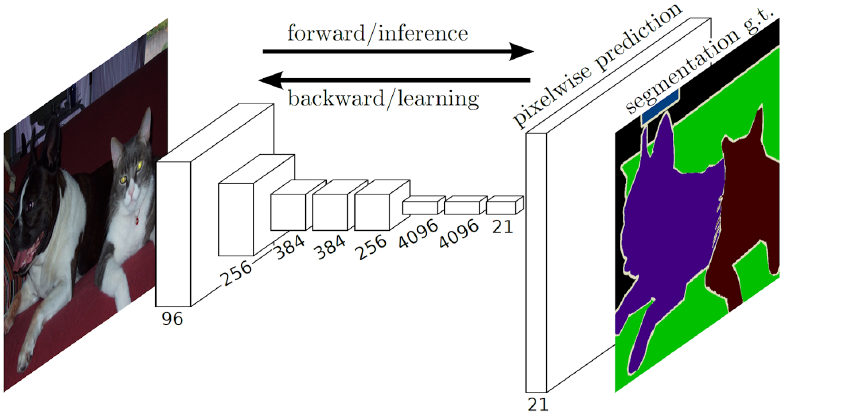
Figure 14. The explained architecture of Fully Convolutional Networks (FCNs). FCN first down- samples and then transforms the image back to the original spatial size using up-convolutions. Using dense predictions, it tries to predict a class label for each pixel in an image and segment the objects based on the classes of pixels. Reprinted from